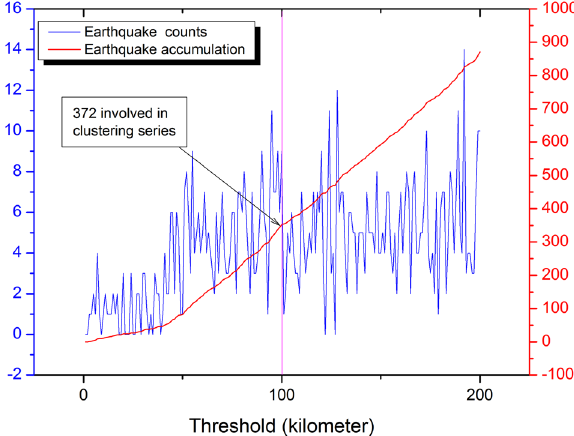
Fig. 8 Space clustering degree. Left y axis: earthquake and disaster counts in cluster series; right y axis: cumulative percentage; x axis: space threshold among disaster mines (100-km threshold and 2-day time threshold)